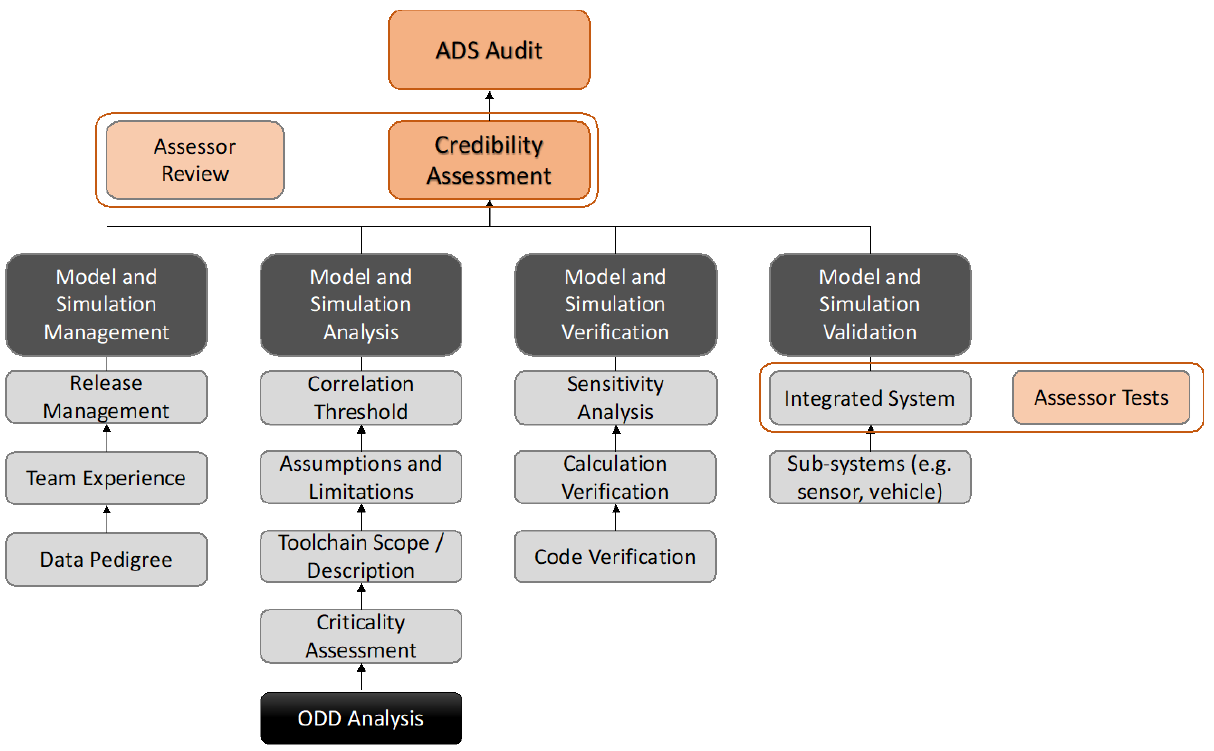
Figure 3. Authors’ own elaboration based on the Simulation Credibility framework